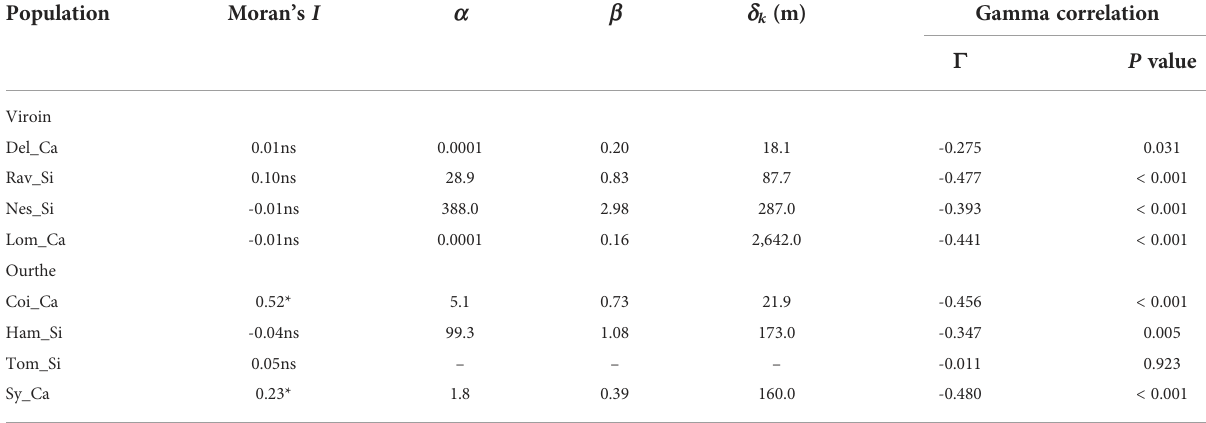
TABLE 4 Results of dye dispersal distribution patterns within eight calcicolous (Ca) and silicicolous (Si) populations of Silene nutans from the Viroin and the Ourthe valleys: Moran ’ s I spatial autocorrelation statistics, best fi tting a (extent of dye dispersal) and b (shape of dye dispersal curve), d k (mean distance of dye transfer), and Gamma correlation coef fi cient ( G